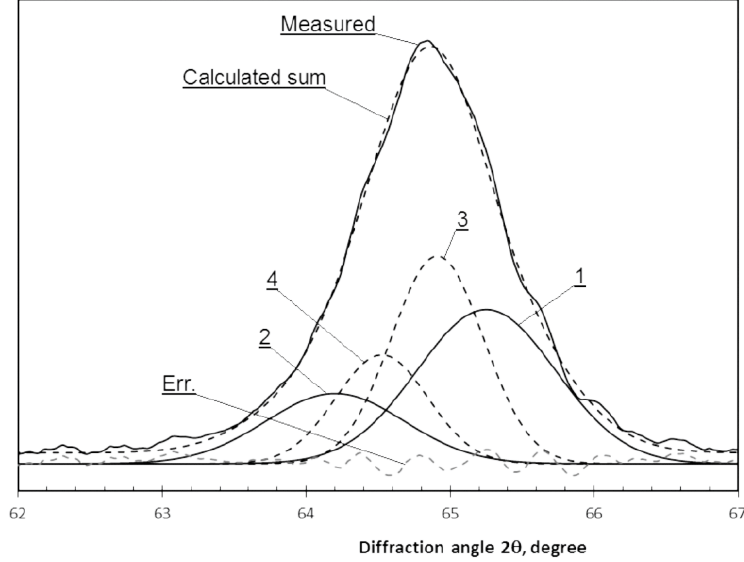
Figure 7. Multiple Gaussian peaking fitting to separate the (200) α peak as four sub-peaks of the M plate and M lath sub-phases as labelled: 1—(200) of M plate , 2—(002) of M plate , 3—(200) of M lath , and 4—(002) of M lath